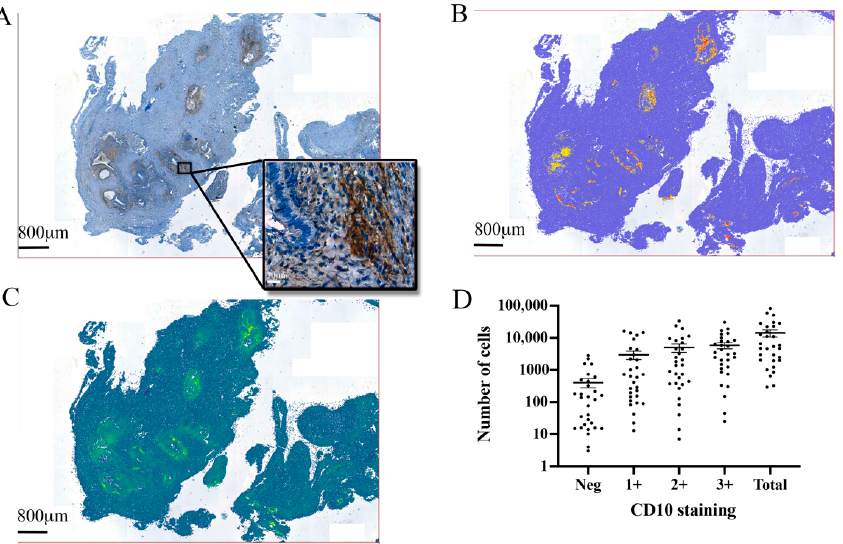
Figure 1. CD10 and the automated identification of endometrial stromal cells in excised endometriotic tissue. ( A ) Mouse anti-CD10 antibody-labelled endometrial stromal cells in the excised tissue, revealing multiple endometriosis foci. ( B ) Automated cell detection was performed with QuPath software over the entire excised lesion. ( C ) Pixel smoothing identified the size of each endometriosis foci, each individual cell within the lesion, and the relative staining intensity of each cell. ( D ) Total cell counts showed the number of stromal cells identified by automated software and the number of cells that were considered either negative for CD10 staining, lightly (1+), moderately (2+), or heavily (3+) immunoreactive for CD10.